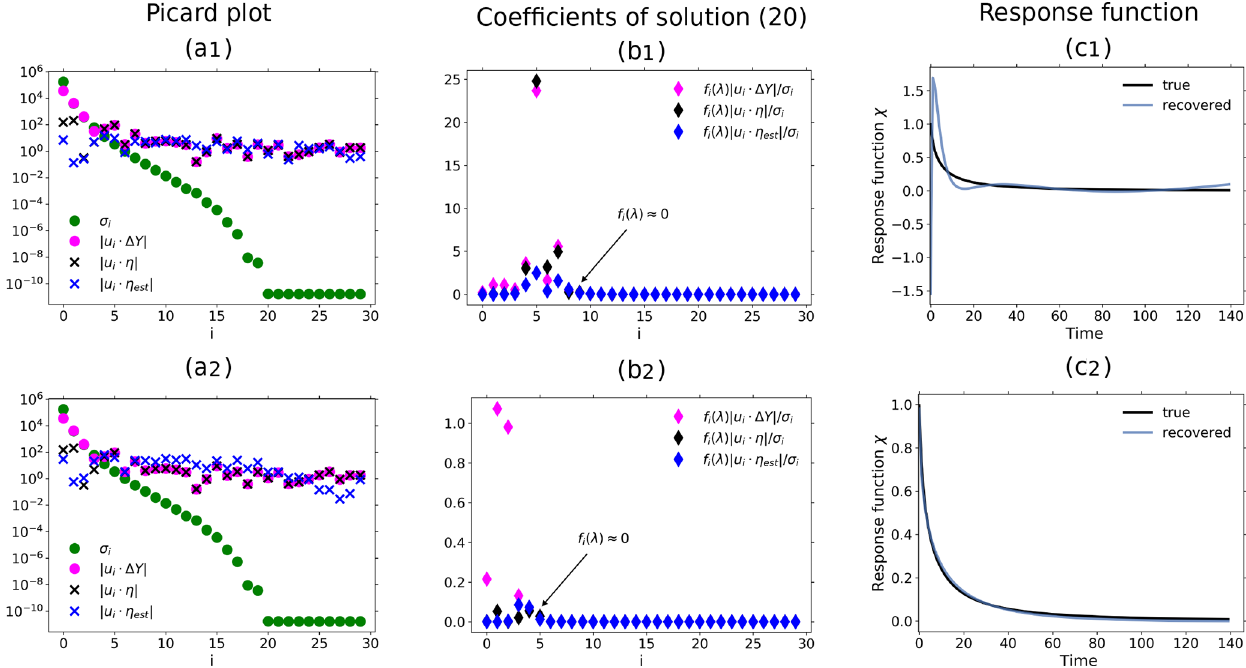
Figure 6. Demonstration of the additional noise-level adjustment in the presence of a monotonicity constraint using toy model data from a 1% and control experiment: (a) Picard plot; (b) coefficients of the regularized solution (Eq. 20) and (c) recovered linear response function. All the figures are based on the same toy model experiments using a SNR = 1189. To demonstrate the effect of the noise-level adjustment, the spectral similarity assumption is broken by artificially increasing the low-frequency components of the noise in the experiments. The plots in the first row show the results from the RFI algorithm in the absence of additional noise-level adjustment (step 6 in Fig. 1). Although the “true” response function of the toy model is monotonic, the response function recovered by the RFI algorithm is non-monotonic (last figure in the first row). However, if the noise adjustment is switched on (second row), the response function is correctly recovered as monotonic (last figure in the second row). Arrows in subfigures (b) indicate the index i critical that separates components of the solution that are only weakly suppressed ( i < i critical ) from those that are almost completely suppressed ( i ≥ i critical ). The regularization parameter determined by the algorithm is λ ≈ 1 for the first row and λ ≈ 11450 for the second. For more details, see the